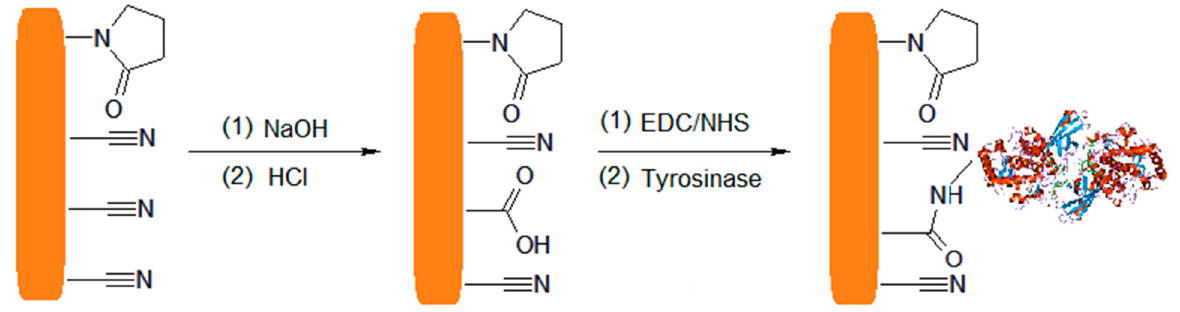
Figure 6. Reactions occurring between sublayer, capture agent and enzyme.